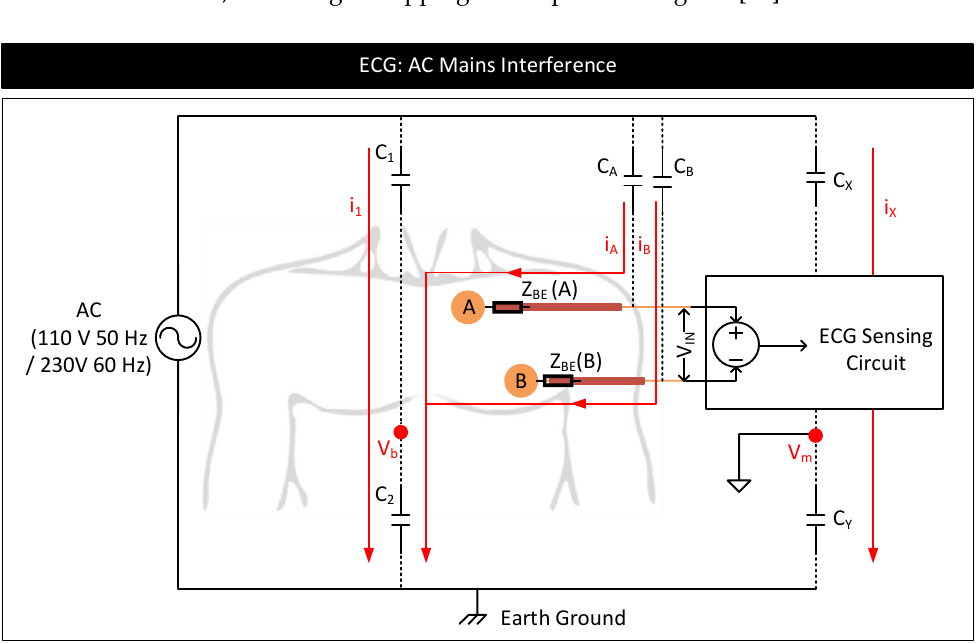
Figure 16. AC mains interference model of an ECG measurement